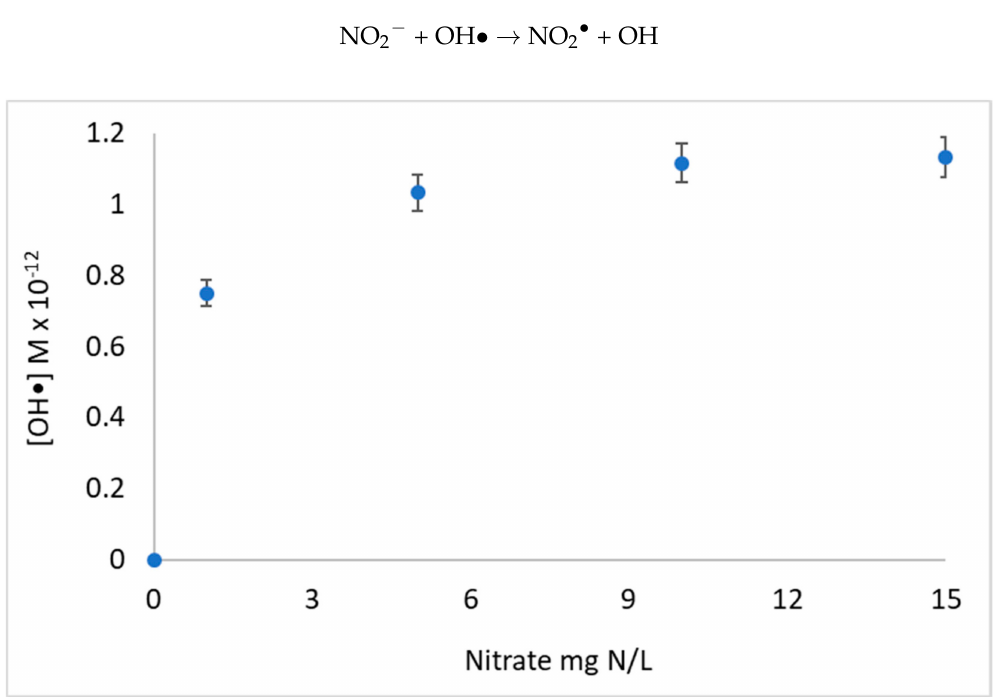
Figure 3. The concentration of OH • during the irradiation of varying nitrate concentrations with medium pressure (MP)